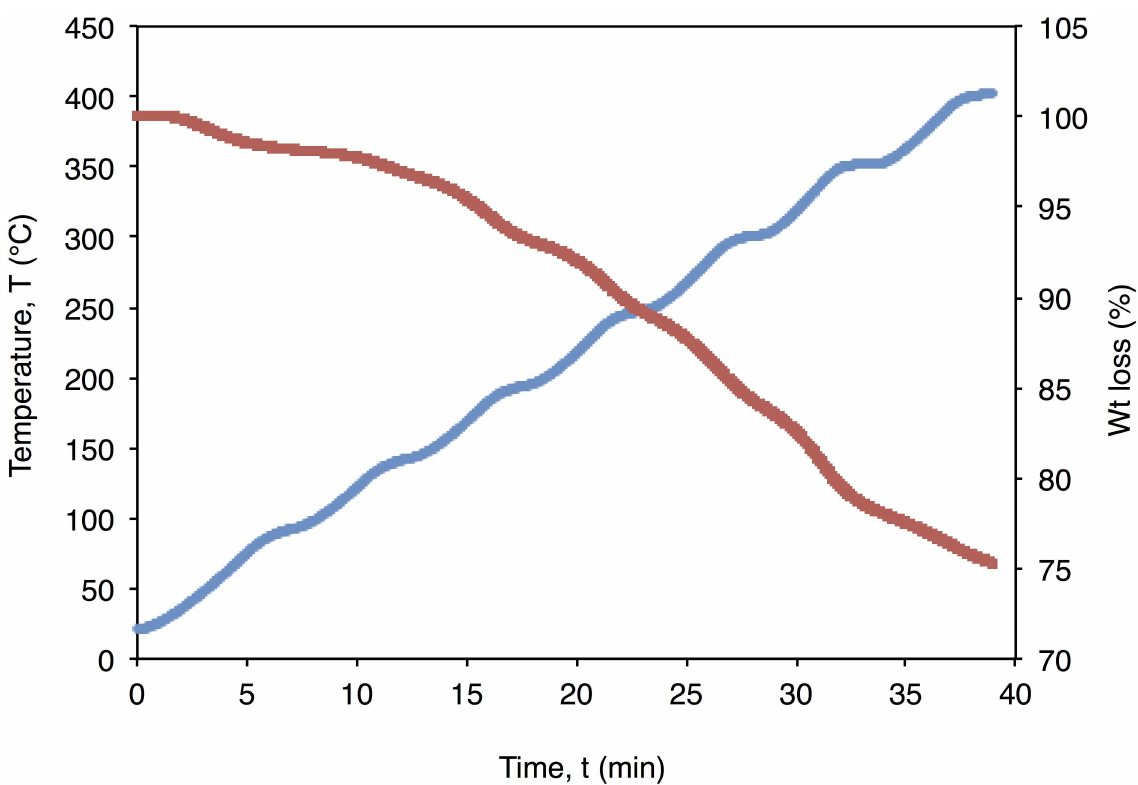
Fig 4. Thermo gravimetric analysis (TGA) of the extract loaded into pSi. Weight loss curve (in red), heatingcurve (in blue) of crude leaf extract loadedpSi (10 mg) was hated in N 2 at a ramp rate of 10˚C/ min to a temperature of 400˚C beyond this no further degradation was observed.